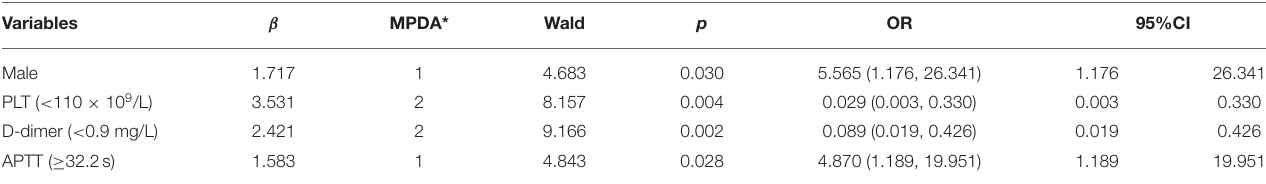
TABLE 6 | Multivariate logistic analysis of independent risk factors associated with APS-PE.